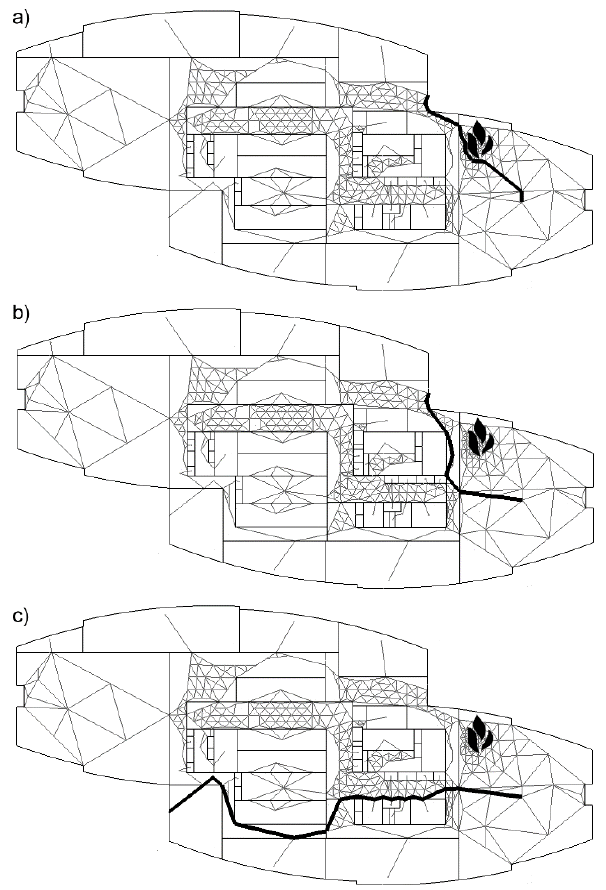
Figure 4. Paths from the selected room with the hazard event to an exit from the building: a) the shortest path ( τ = 1.0); b) short and safer path ( τ = 1.141); c) more safer but longer path ( τ = 1.354).